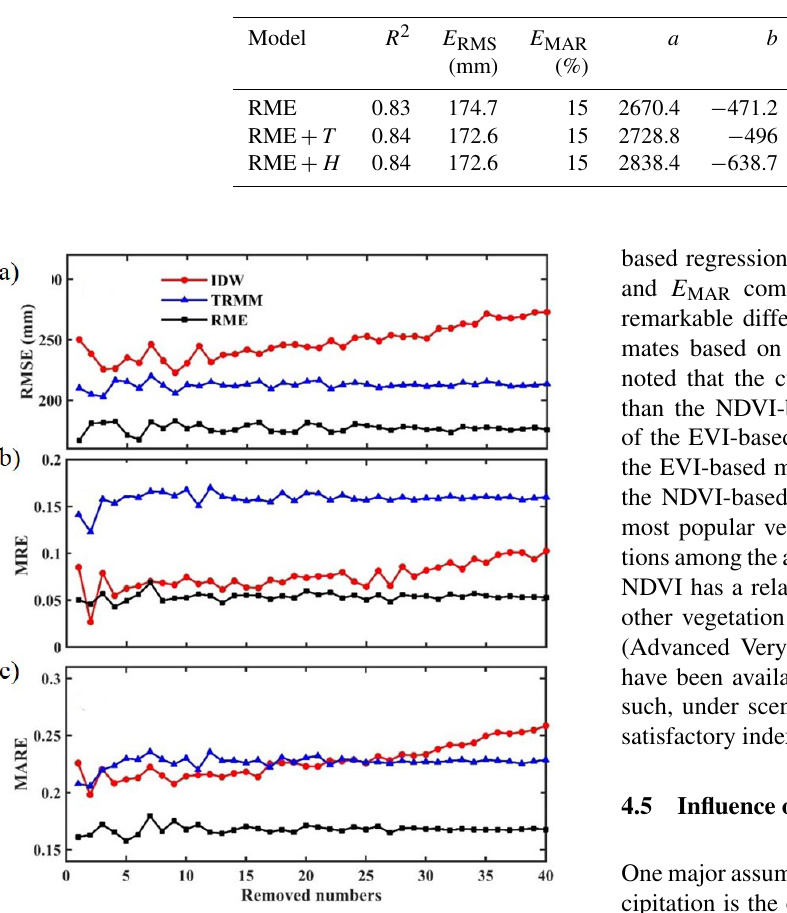
Table 5. Results of two regression models established with extra independent variables: RME + T for temperature, RME + H for elevation.